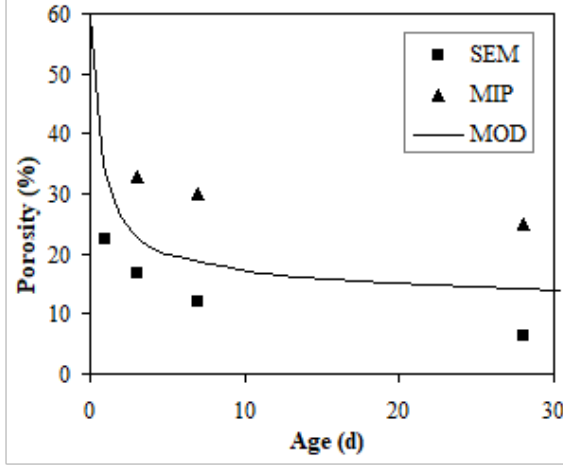
Figure 5: Degree of hydration of cement paste as a function of hydra- tion time. Figure 6: Porosity of cement paste as a function of hydration